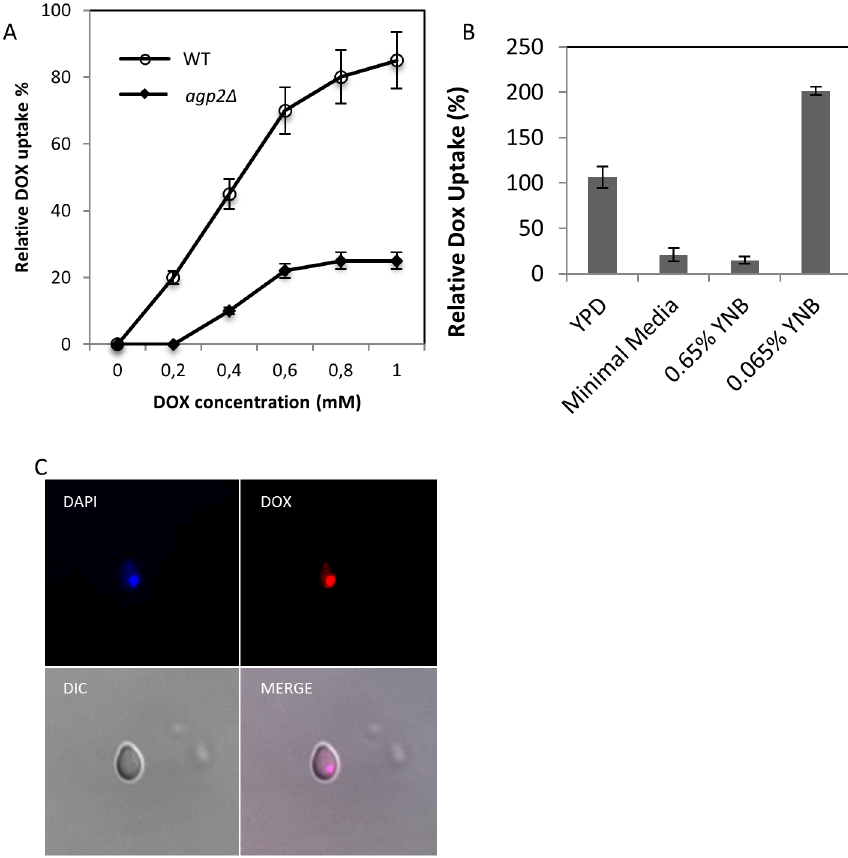
Fig 1. Relative DOX uptake into yeast cells in rich and minimal media, and localization of the drug to the nucleus. (A)Concentration dependent uptake of DOX into the wild type (WT) strain BY4741. Cells were grown in YPD media overnight and subcultured into the same media for 1 h followed by the addition of increasing concentration of DOX and uptake was stopped after 10 min. The intracellular accumulation of DOX was monitored using FACS analysis. The agp2 Δ mutant defective in DOX uptake is described below. (B)Comparison of DOX uptake in YPD, minimal media, and media containing normal amount (0.65%) of yeast nitrogen base (YNB) and 10-fold less YNB (0.065%). The WT strain was incubated in the indicated media with 800 μ M of DOX for 30 min, and the intracellular accumulation of the drug was measured by FACS analysis. For panels A and B, the results were the averages of three independent analyses. (C)Epifluorescent microscopy showing intracellular colocalization of DAPI and DOX in the WT strain. The WT cells grown in YPD were transferred to low YNB followed by the uptake of DOX (100 μ M) for 30 min. The fixed cells were processed for microscopy using mounting medium containing DAPI to detect the nuclear DNA. Images were captured with a DeltaVision (see material and methods). DIC, differential interference contrast; Merge, colocalization of DAPI stained nucleus with